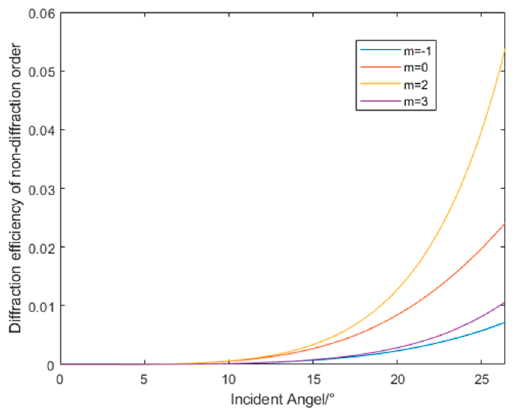
Figure 4. Diffraction efficiency of non-diffraction order versus incident angle.